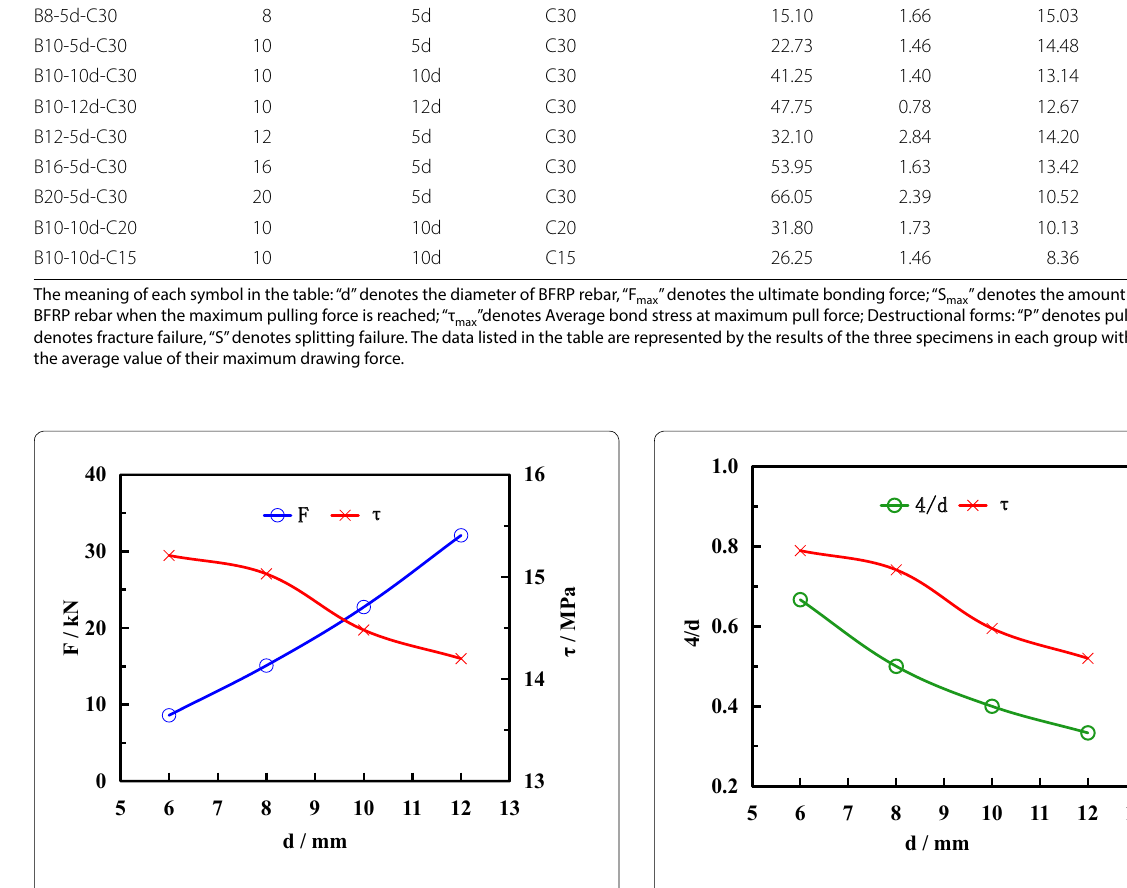
Fig. 7 Relation of bond force and bond stress to the rebar diameter. Fig. 8 Relation of bond area and bond stress with the diameter of the FRP